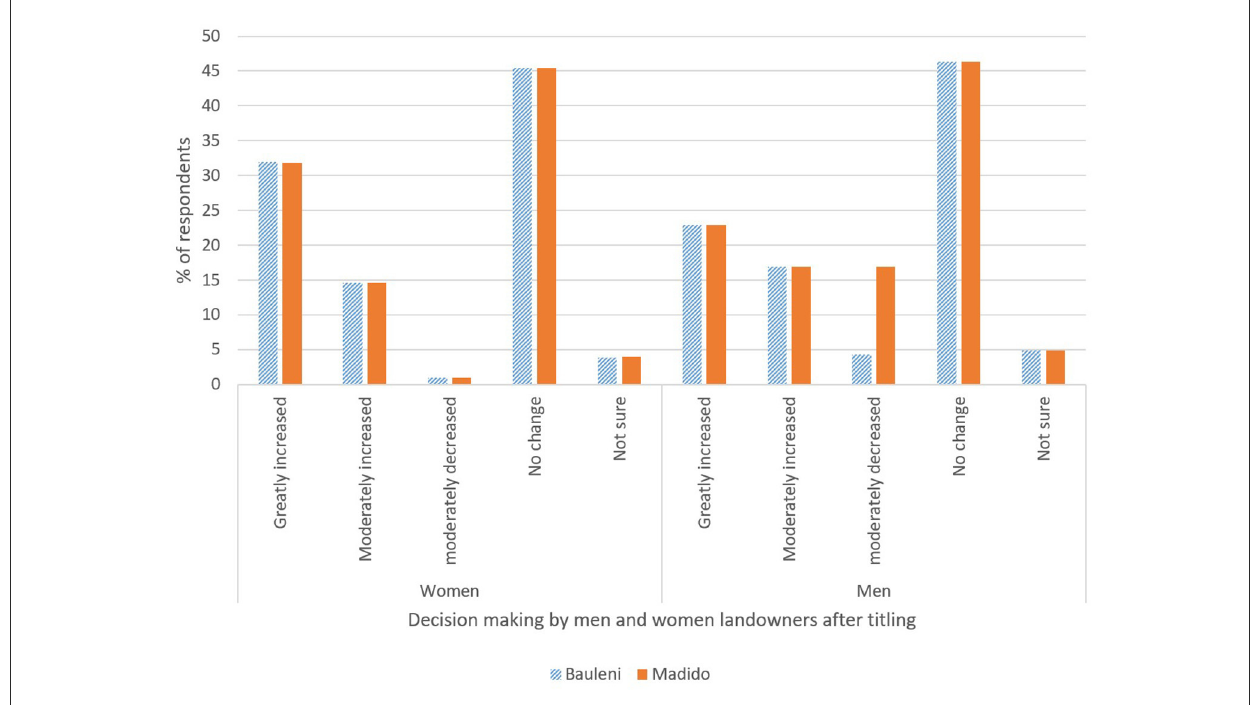
FIGURE9 Decision making by men and women landowners in Bauleni and